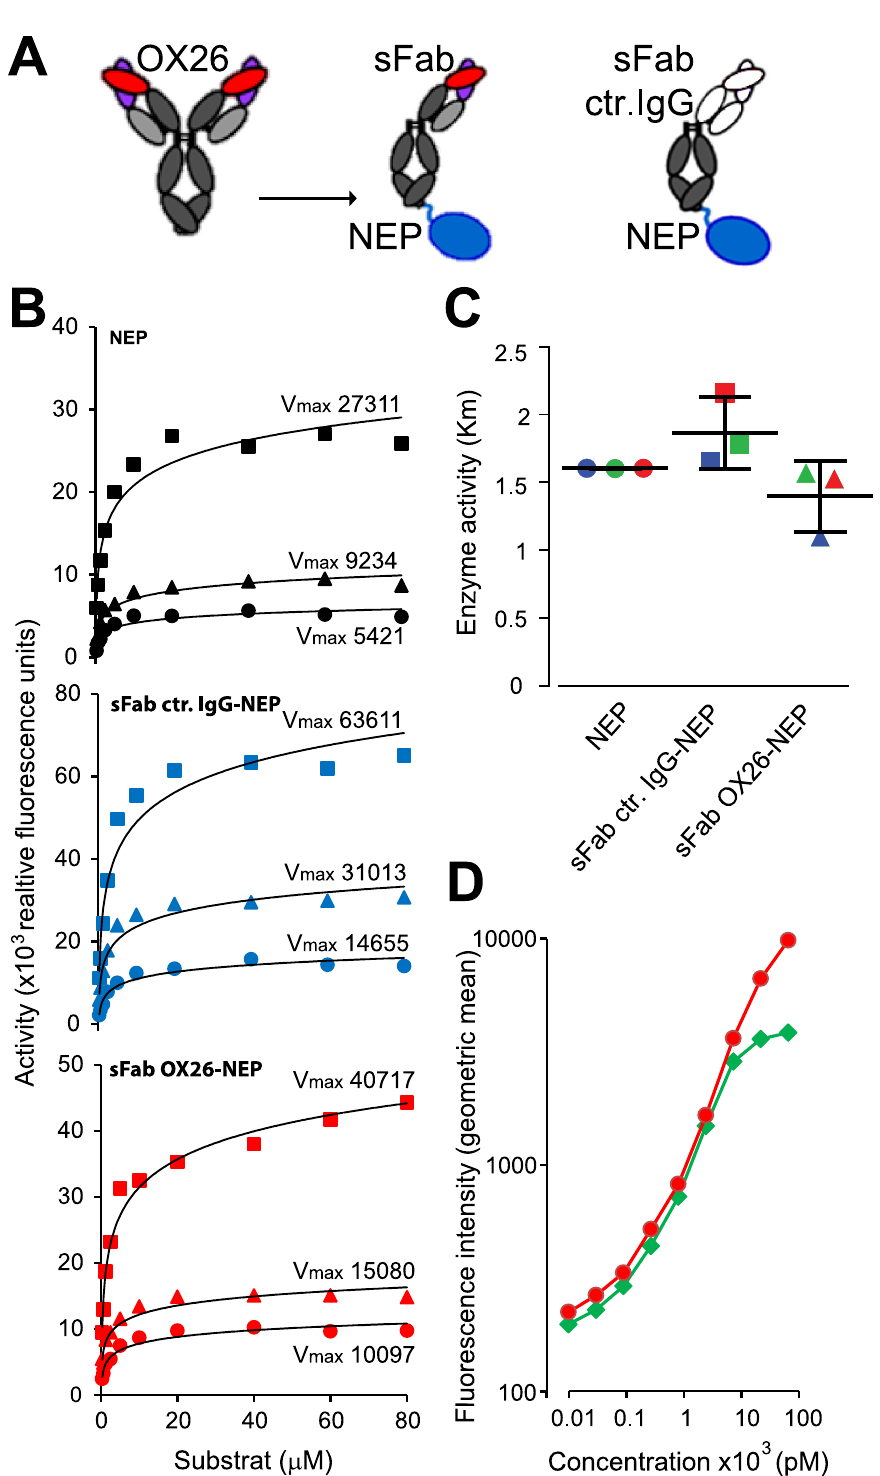
Fig 1. Recombinant sFab OX26-NEP fusion protein is active in vitro . (A) Schematic Representation of the OX26 antibody, the one-armed OX26-NEP (sFab OX26) and control IgG-NEP (sFab ctr IgG) fusion constructs. The OX26 Fab fragment (red/magenta) that binds the TfR or the inert control Fab (white) are fused over the C-terminal end of the Fc region (gray) to the human NEP (blue). (B) Enzymatic activity measurements for NEP (black), sFab ctr IgG-NEP (blue) and sFab OX26-NEP (red) at construct concentrations of 4nM (squares), 2nM (triangles) and 1nM